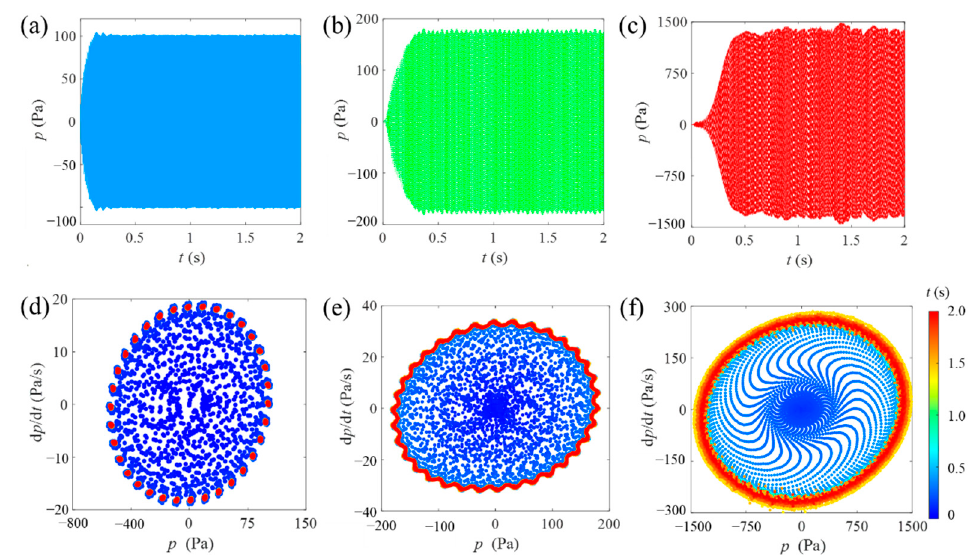
Figure 8. ( a – c ) Time domain signal of pressure fluctuations and ( d – f ) corresponding phase diagram. ( a ) and ( d ) V a = 130 L/min, ( b ) and ( e ) V a = 180 L/min, and ( c ) and ( f) V a = 250 L/min, where S N = 0.45 T i = 300 K.